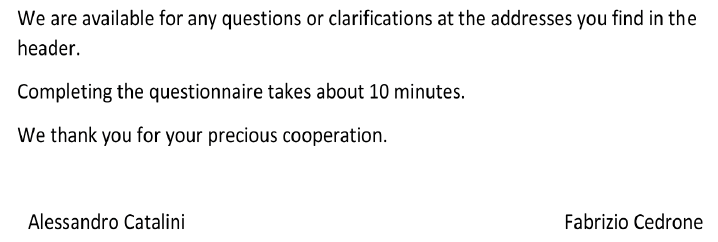
Figure A1. Cover Figure A1. Cover letter.